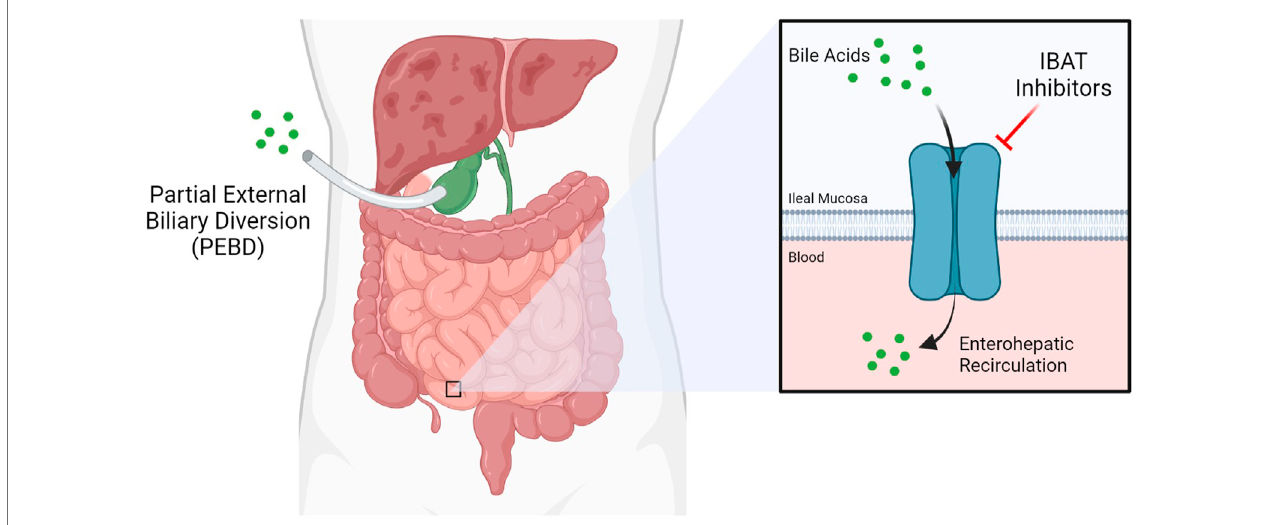
FIGURE 1 | Current therapeutic approaches for Alagille Syndrome include inhibitors of the Ileal Bile Acid Transporter (IBAT) such as maralixibat, which limit enterohepatic circulation, and Partial External Biliary Diversion (PEBD), a highly invasive procedure.